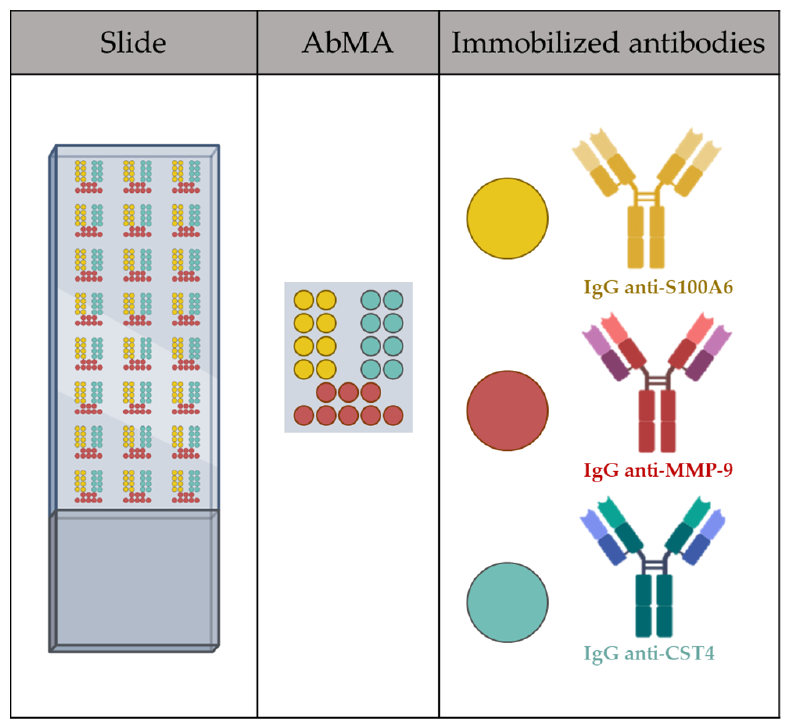
Figure 1. Representation of a microscope glass slide with the printed AbMAs. There were 24 AbMAs immobilized onto treated slides, each one with eight spots of the 3 biomarker IgGs at 200 µg/mL in SIVG (0.05%). Image created with BioRender.com. Three different antibodies, each directed against one of the selected tear protein biomarkers (S100A6, MMP-9 and CST4) were immobilized in the AbMAs and used to quantify the markers in the 32 tear samples. The immunodetection protocol was performed by first thawing and drying the slides for 30 min at RT in a drying chamber, and they were then washed three times for 5 min with phosphate buffer saline containing